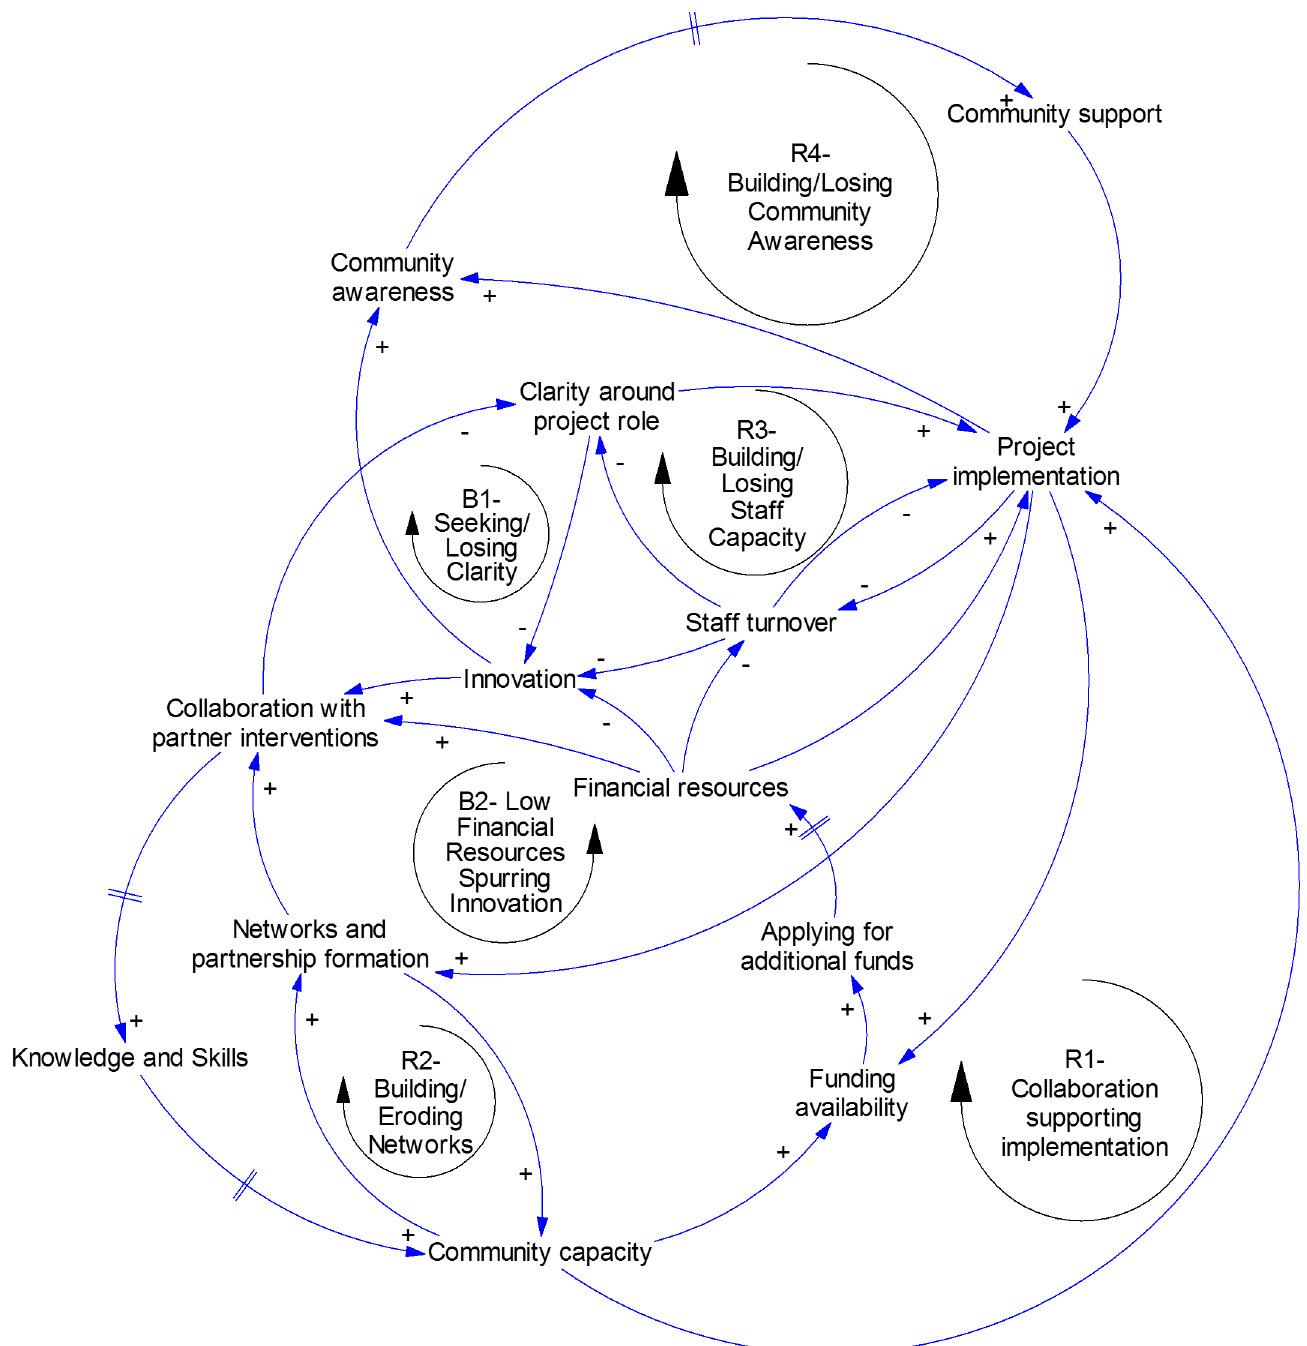
Fig 1. Causal loop diagram of Romp &